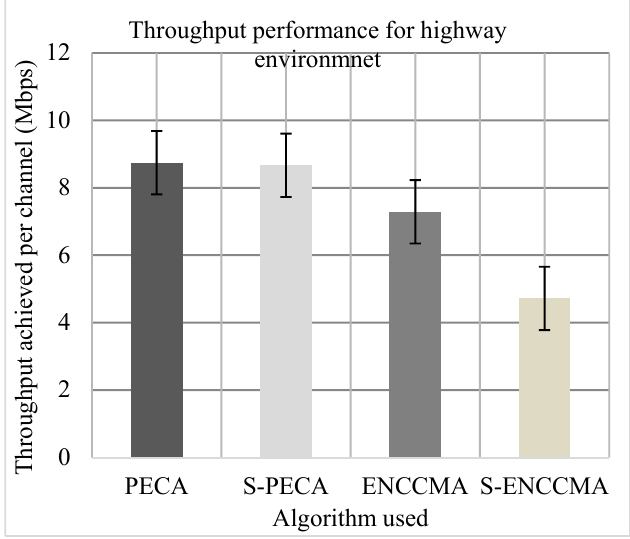
Algorithm used Algorithm used Figure 8. Throughput performance for highway environment. Figure 8. Throughput performance for highway environment. Figure 8. Throughput performance for highway